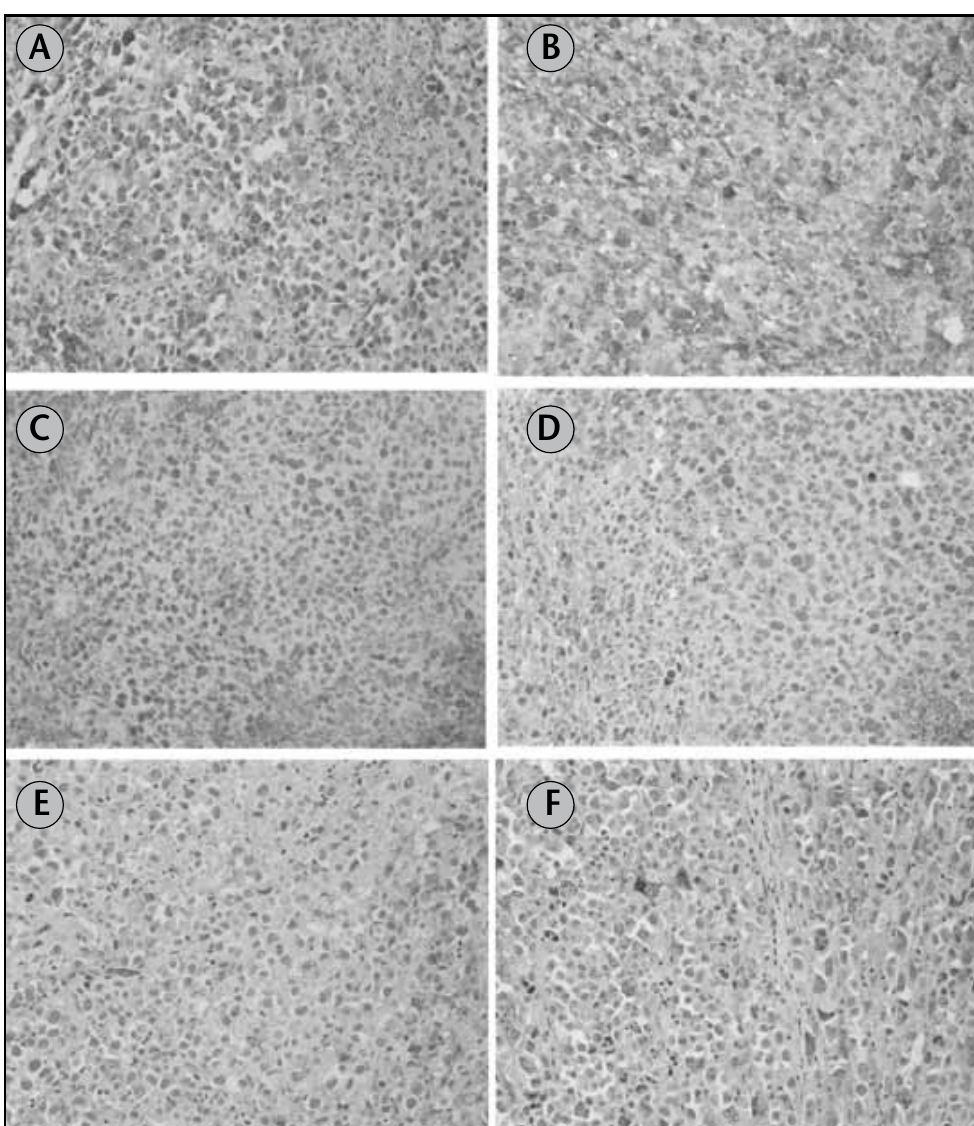
Figure 3 – Immunohistochemical reaction to CDC47/MCM-7 protein in Ehrlich tumor Group 1: control (A) and treated (B) animals at day 6 post tumor cell inoculation; group 2: control (C) and treated (D) animals at day 12; group 3: control (E) and treated (F) animals at day 18. Nuclear immunolabeling, showing low number of positive cells in Kint3-4 treated animals of the three groups. 400 ×